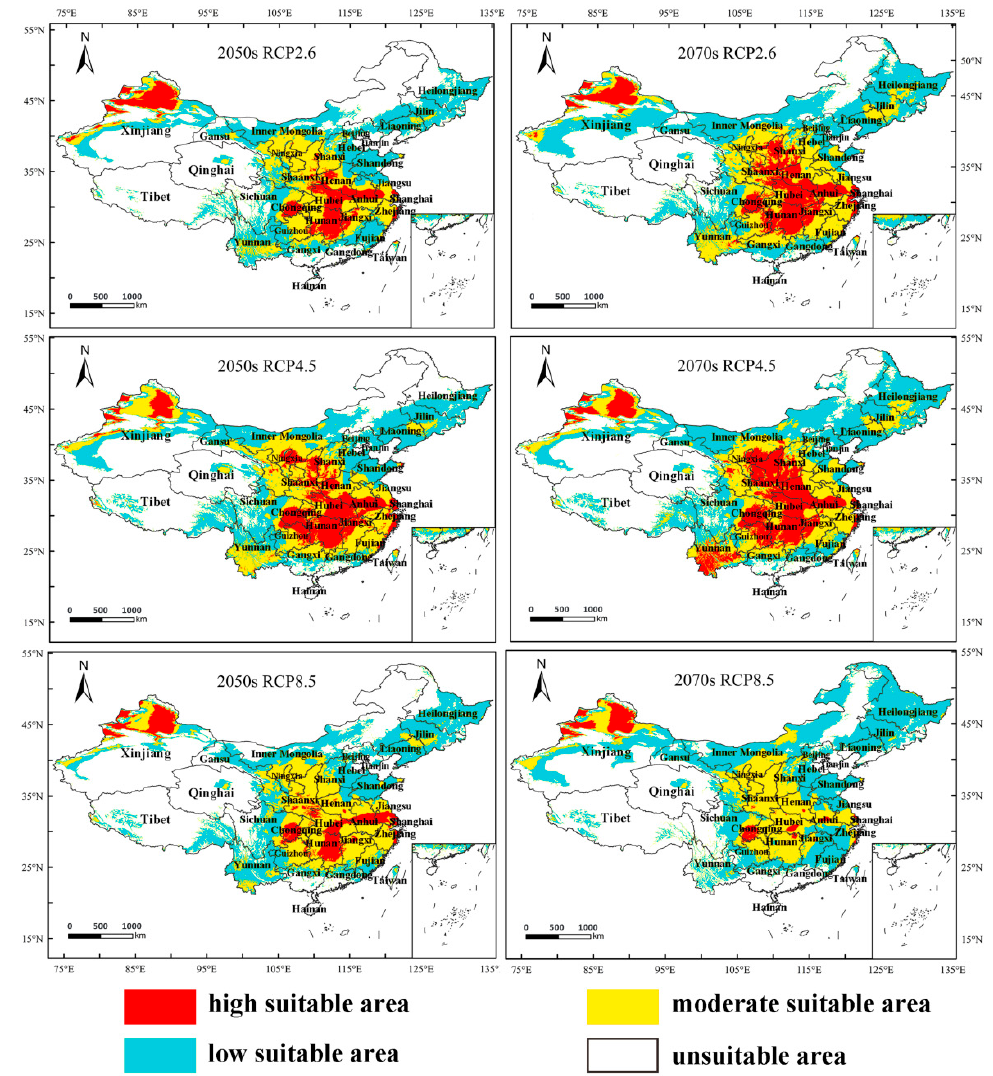
Figure 8. The predicted potential distribution area of M . destructor in China under three different climate scenarios in the future.